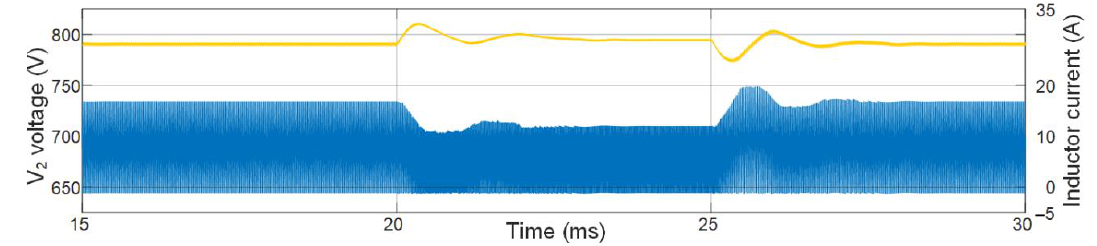
Figure 10. Simulation results for load steps in QSW-ZVS. Power flows from V 1 to V 2 and changes from 3 kW to 2 kW at t = 20 ms and from 2 kW to 3 kW at t = 25 ms are provided. V 2 in yellow and I L in blue.